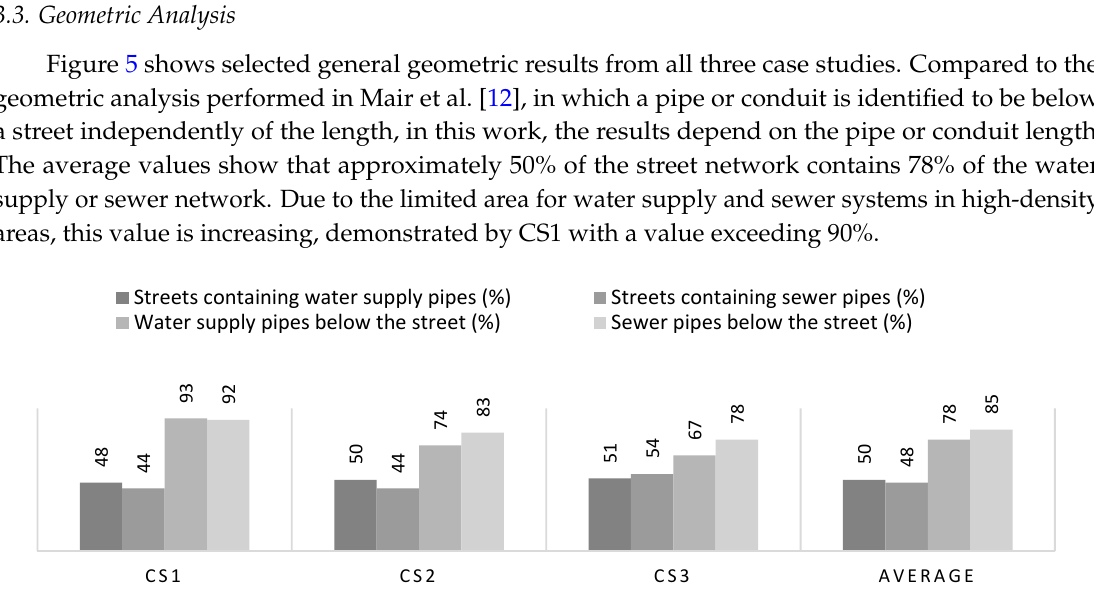
Figure 5. Street type independent geometric results of various street types.